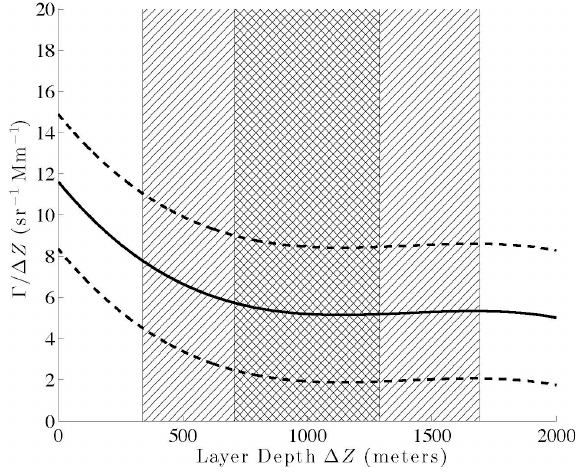
Figure 6. The normalized integrated attenuated backscatter as a function of the layer depth. The solid line shows the third-order least squares fit to the data while the dotted lines show ± 1 σ ; the hatched area shows the layer depth data frequency: cross hatch be- tween the 25th and 75th percentiles and straight hatch between 5th and 95th